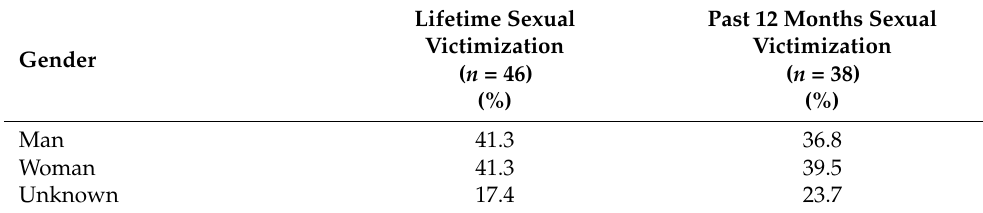
Table 4. Identified gender of the assailant of sexual violence.